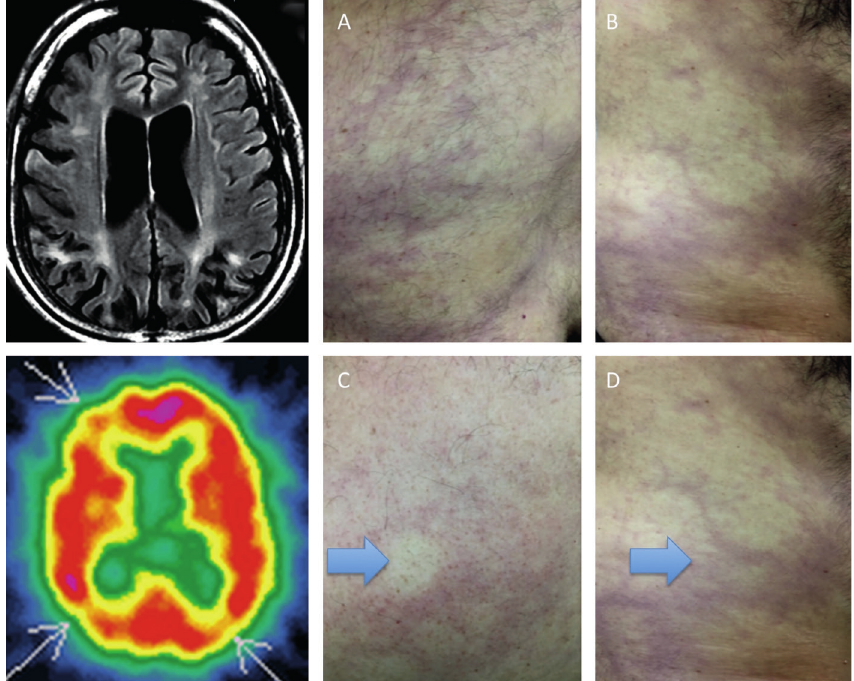
Figure 1. Right side with blue arrows – Livedo reticularis diffusely spread throughout the thoracic and ab- dominal circumference (A,B,C and D), with rapid return with finger pressure (C with blue arrow). Upper left. Axial Flair Brain MRI shows multiple areas of infarction in cortico-subcortical regions and in white matter, and diffuse brain atrophy and perfusion with 99mTc-ECD – Brain SPECT shows marked diffuse hypoperfu- sion in parietal and frontal lobe areas (arrows).